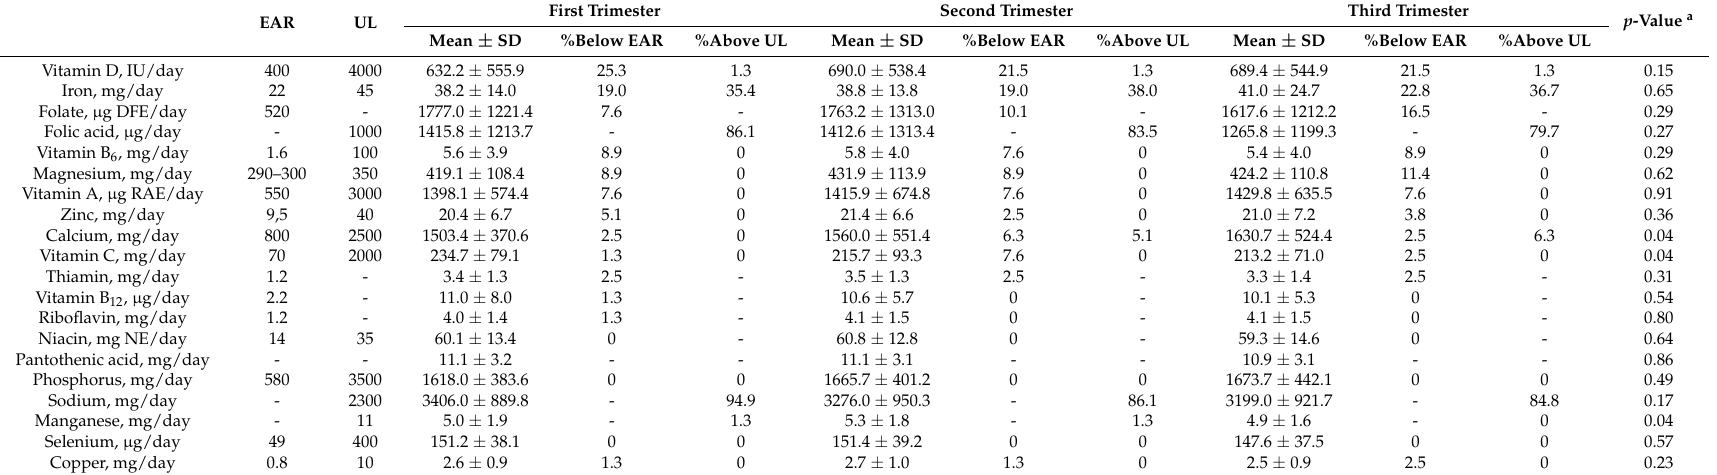
Table 5. Trimester-specific total micronutrient intakes (including food sources and supplements) in comparison with dietary reference